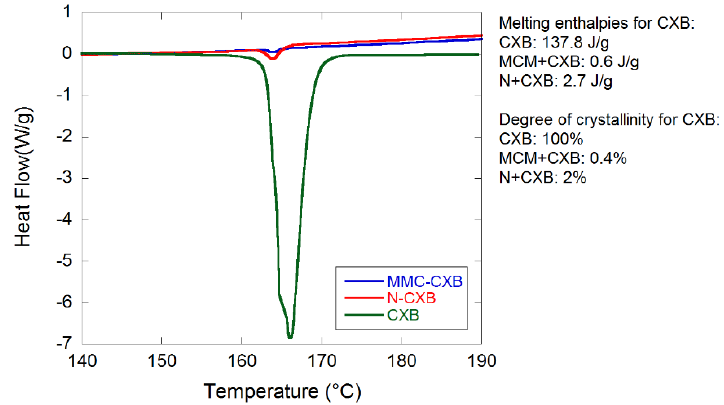
Figure 3. DSC scans of pure and loaded CXB in MMC and Neusilin.